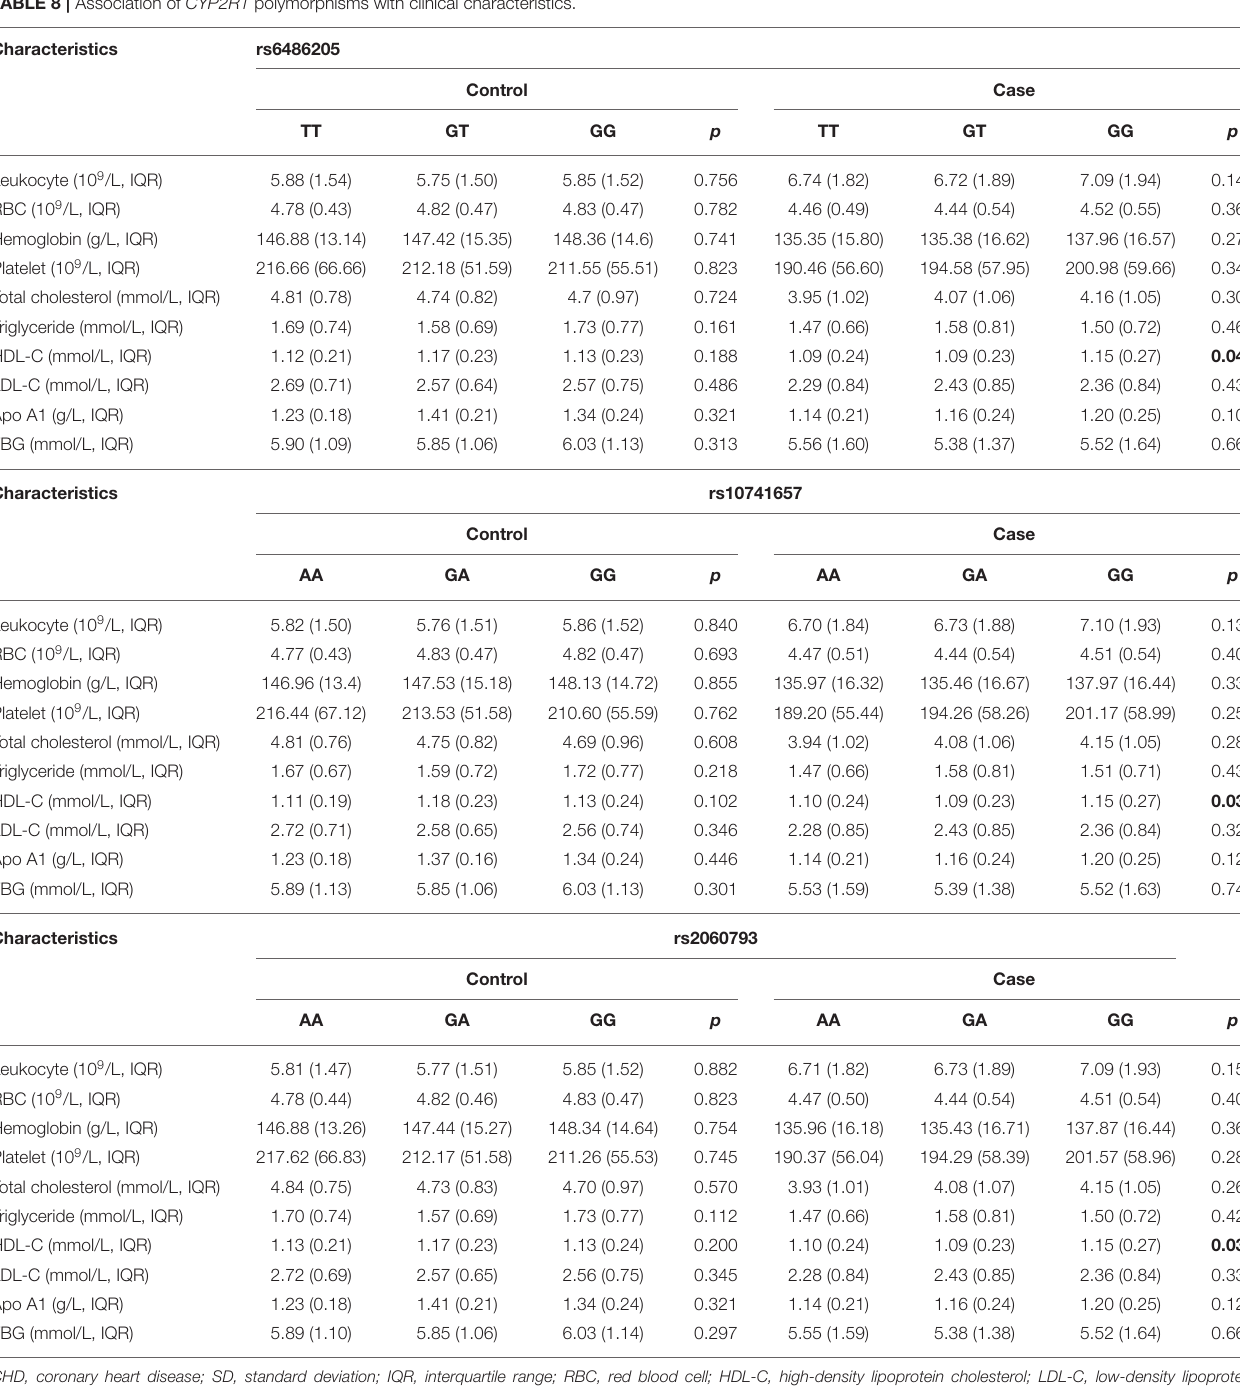
TABLE 8 | Association of CYP2R1 polymorphisms with clinical